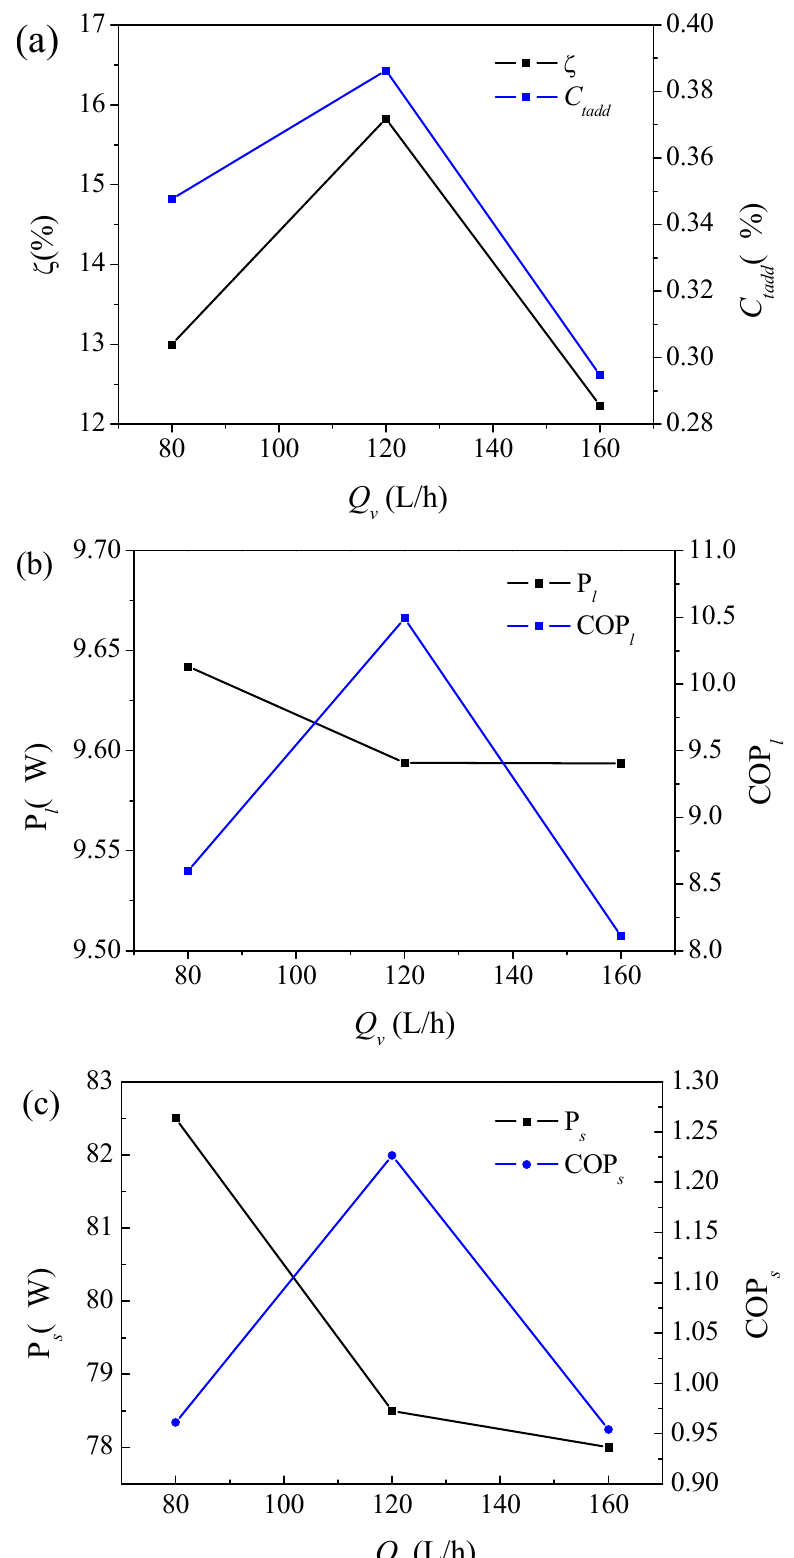
Figure 4. ( a ) E ff ect of flow rate on regeneration performance of electrodialyzer; ( b ) e ff ect of flow rate on performance of electrodialysis regeneration system under theoretical conditions; ( c ) e ff ect of flow rate on performance of electrodialysis regeneration system under test conditions.